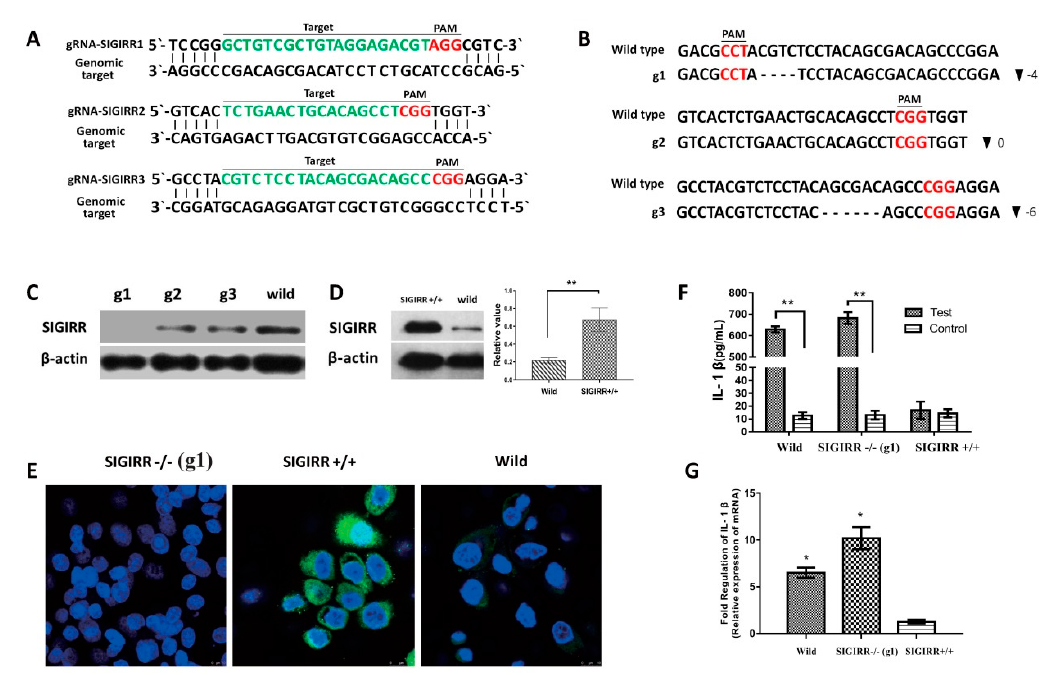
Figure 6. The downregulation of SIGIRR promotes IL-1 β overexpression. SIGIRR was knocked off in porcine alveolar macrophage cell line 3D4/2. ( A ) Graphical representation of targeted gRNA at porcine SIGIRR loci. Targeted genomic loci are indicated in green, protospacer adjacent motifs (PAM) sequences are marked in red. ( B ) Sanger sequencing of genomic PCR products encompassing the genomic-editing site from cells g1, g2, and g3. The wild type reference sequence is shown on the top. The bottom is a targeted sequence with deletions. the size of deletions ( ▼ ) on the right of each allele. ( C ) Western blotting analysis of SIGIRR protein in cells containing CRISPR-Cas9 system plasmids that were selected by puromycin. ( D ) Western blotting analysis of SIGIRR protein in cells containing expression plasmid pCDH-SIGIRR that was selected by puromycin. ( E ) IFA analysis of SIGIRR in g1 (SIGIRR-/-), overexpression cells (SIGIRR+/+), and wild type cells. ( F ) The IL-1 β secretion was measured in wild type, SIGIRR-/-, and SIGIRR+/+ cells at 12 h after PCV2 inoculation. ( G ) The IL-1 β mRNA levels were detected in wild type, SIGIRR-/-, and SIGIRR+/+ cells at 12 h after PCV2 inoculation. Results are mean ± SE of three independent experiments. * represent p < 0.05, ** represent p < 0.01.